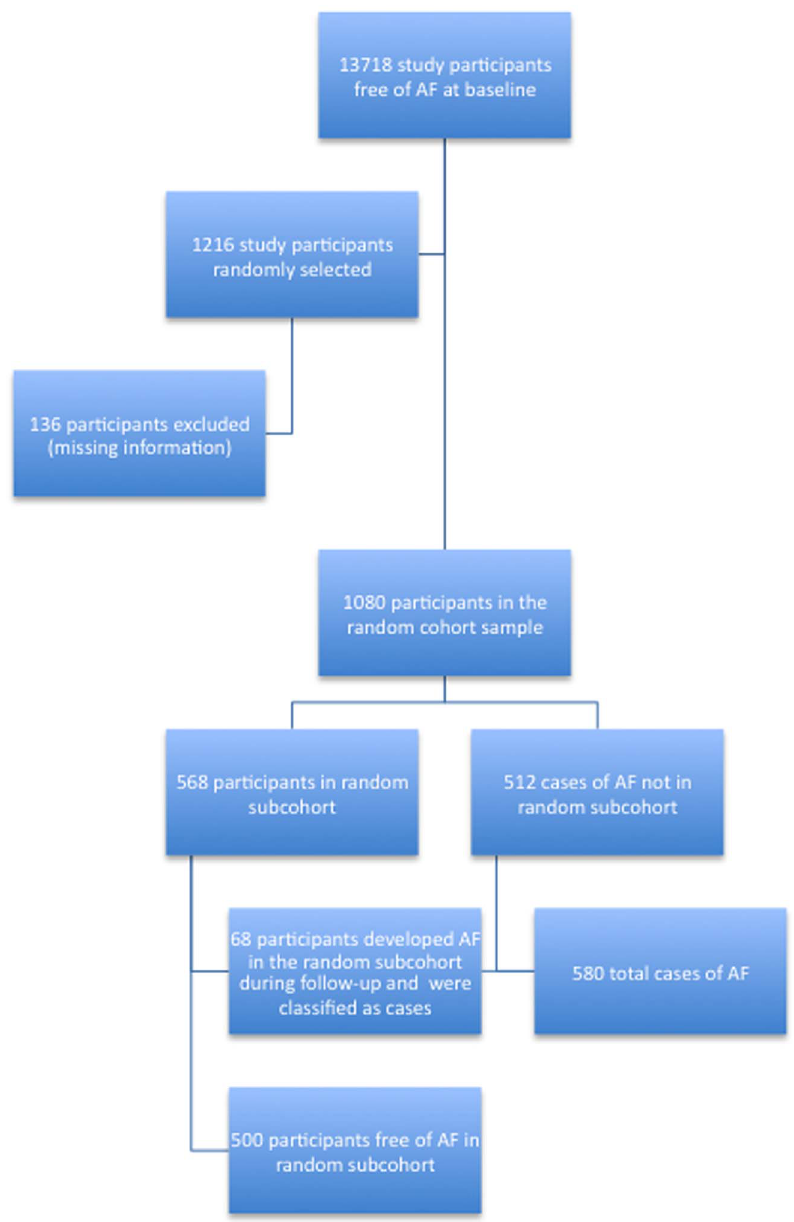
Figure 1. Flowchart of selection of cases and the random subcohort in the Atherosclerosis Risk in Communities Study.